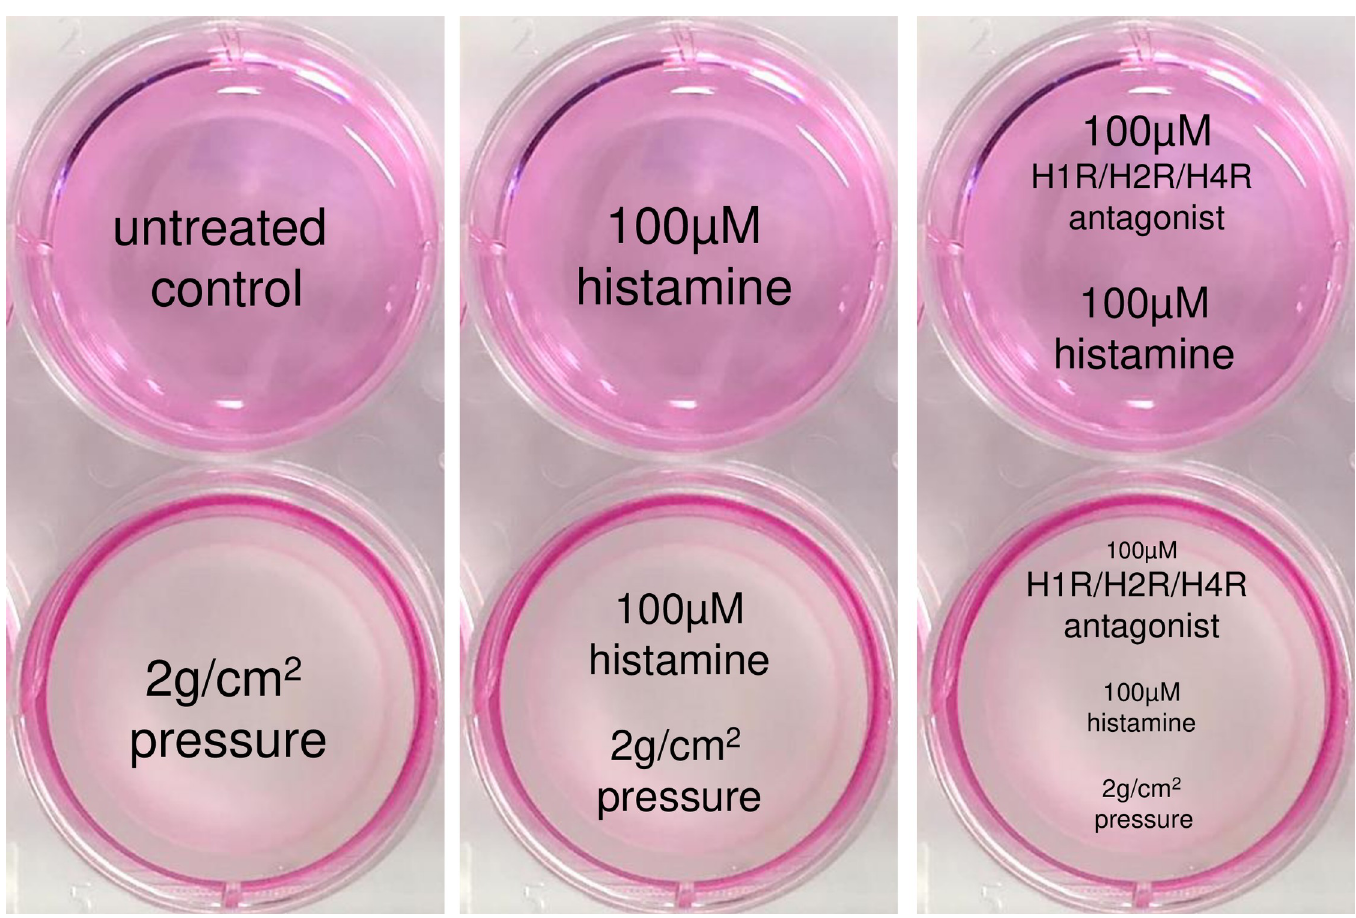
Fig 1. In vitro simulation of compressive force application to periodontal ligament fibroblasts (PDLF) occurring during orthodontic tooth movement. After a preincubation time of 24 h with or without histamine (100 μ M, 50/100/200 μ M in receptor expression experiments) and an H1R/H2R/H4R antagonist (100 μ M), a pressure of 2g/cm 2 was applied to PDLF by means of a sterile glass disc ( ø 33cm, 17.1g) for 48 h according to an established and published in vitro model.